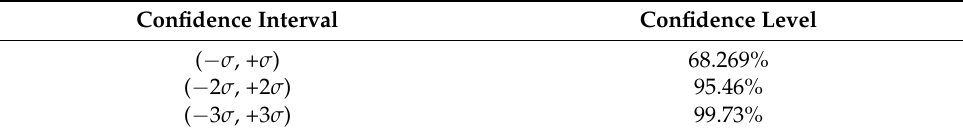
Table 6. Confidence interval and confidence level of stress.